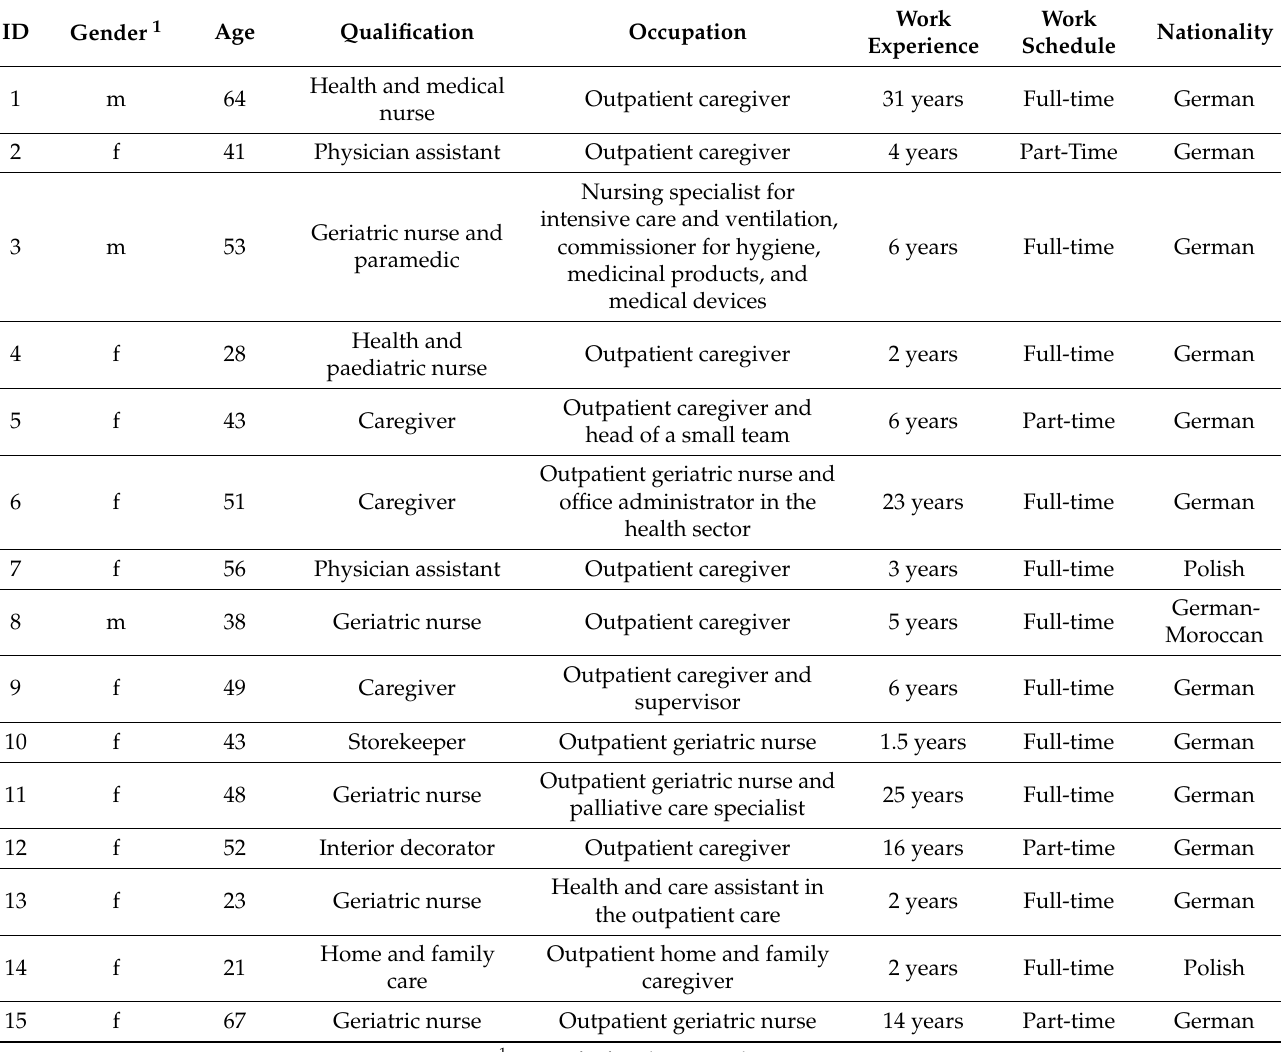
Table 3. Participant